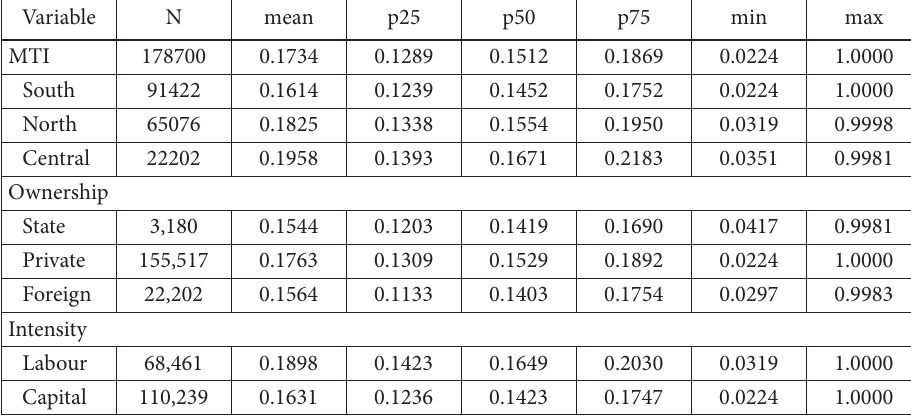
Table 6. Summary of meta technical inefficiency over regions, ownership and intensity (source: Vietnam’s GSO and authors’